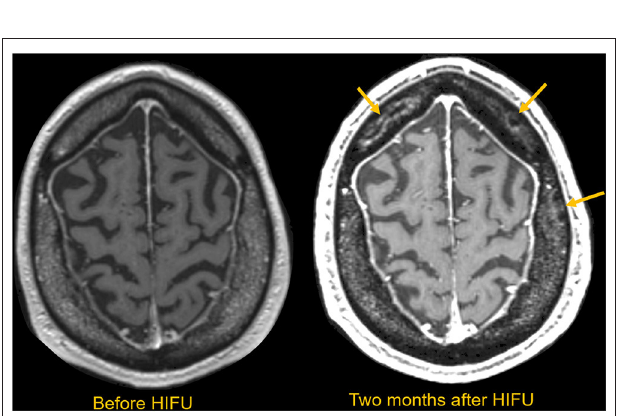
FIGURE 3 | CT images from patients with low and high skull density ratios (SDRs). Both images are windowed the same way, and the skull with high SDR clearly shows increased Hounsfield units.